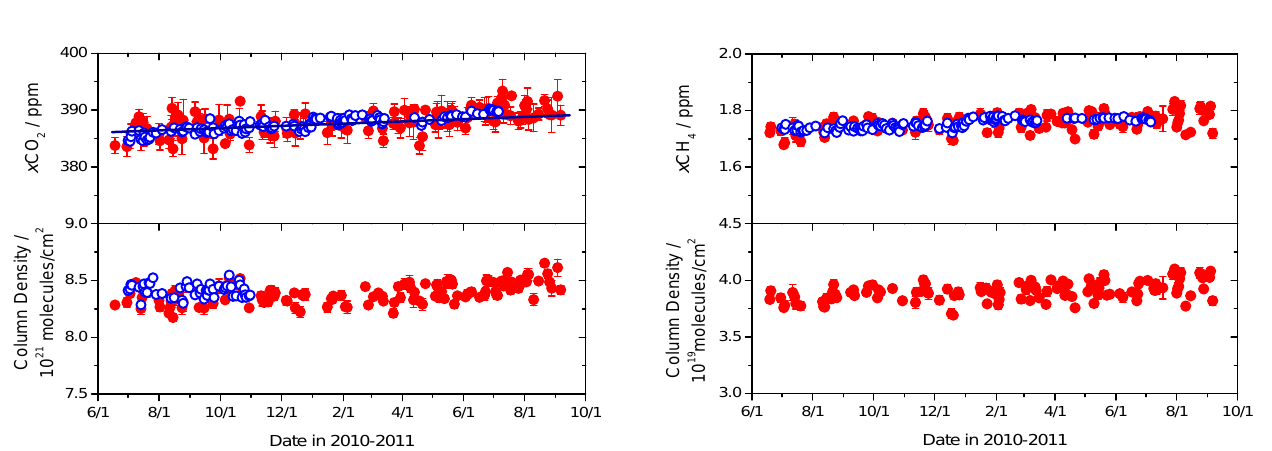
Table 1. Column densities and x CO 2 from the OSA and FTS on 3 July 2010 at the University of Wollongong Australia. Column Standard Uncertainty x CO 2 Standard Uncertainty Instrument density a deviation estimated ppm deviation estimated OSA 8.384 0.031 0.09 b 383.88 1.39 FTS (UoW) 8.429 0.009 0.10 384.48 0.32